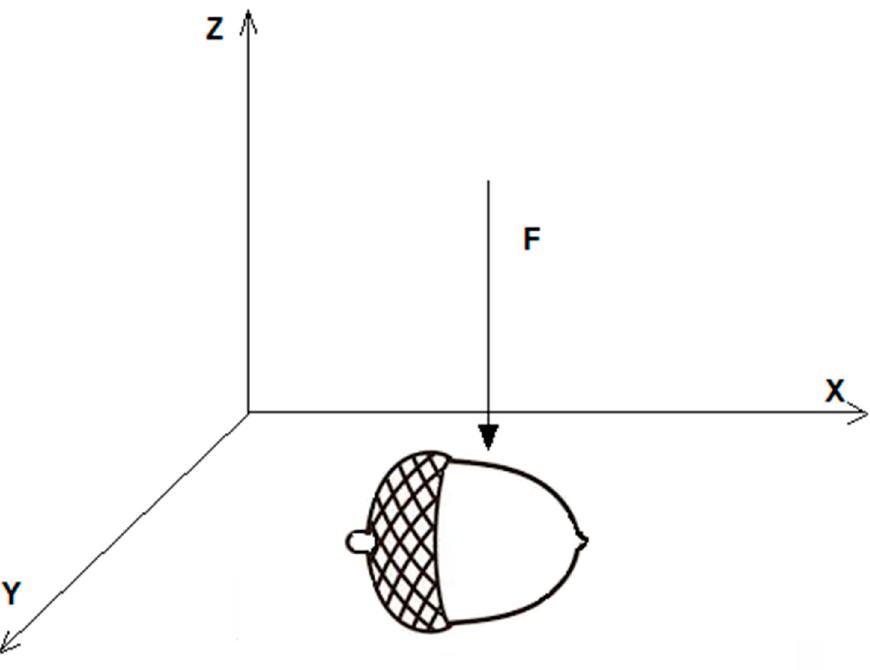
Figure 1. The position of an acorn and penetration probe (P/2N) during force–deformation